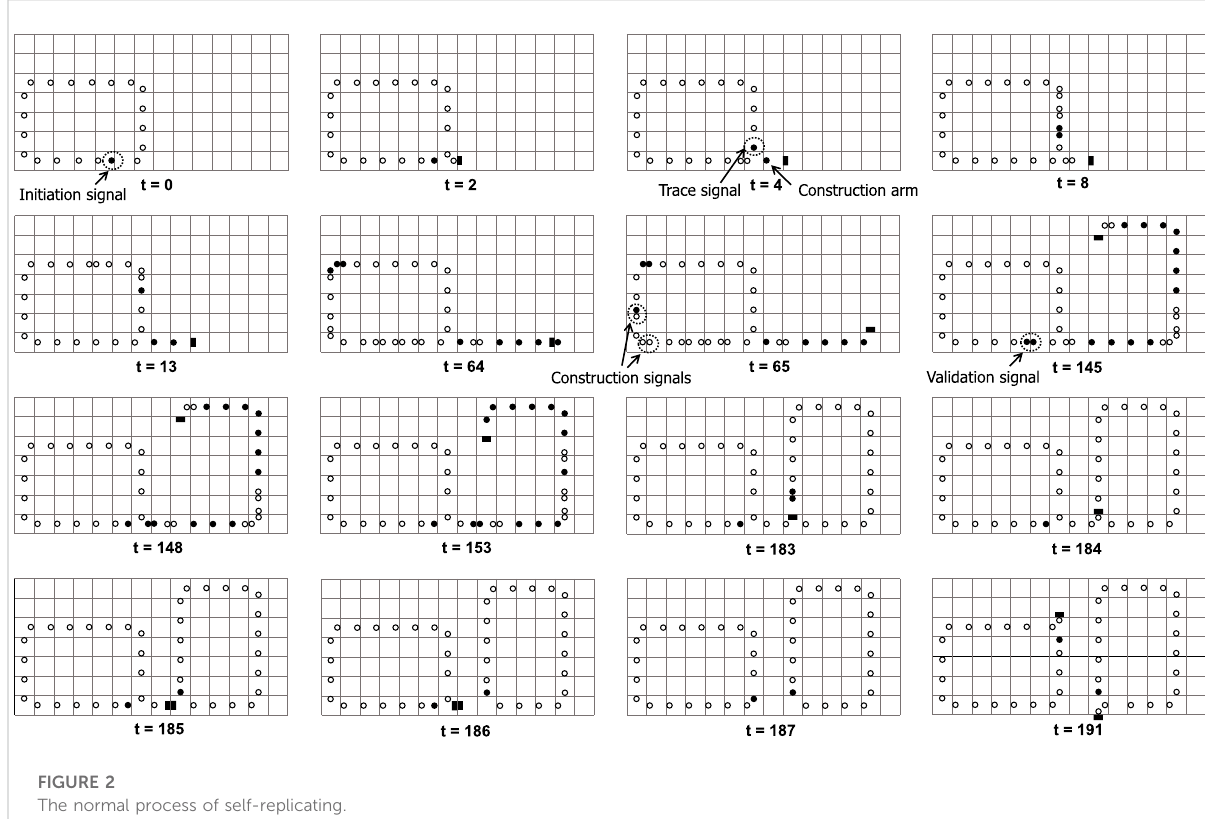
FIGURE 2 The normal process of